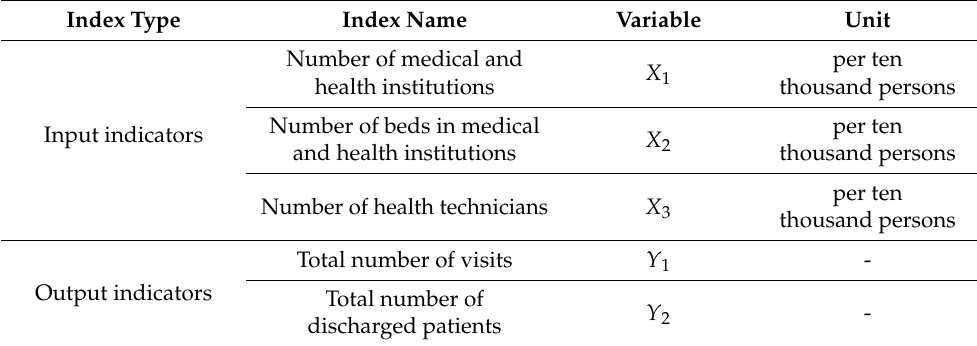
Table 1. Definition of